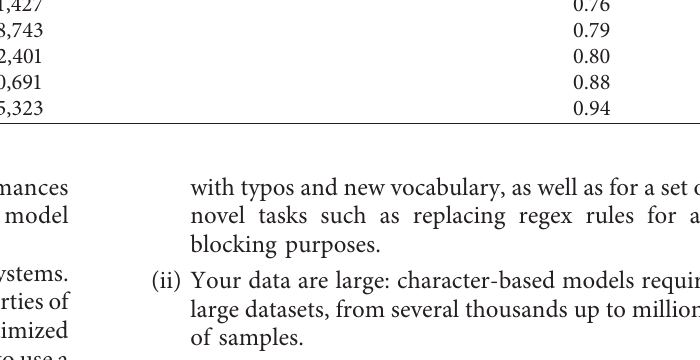
Generative LSTM- independent comp. [30] Generative LSTM-shared comp. [30] Char shallow-and-wide CNN [23] Word shallow-and-wide CNN [23] CharTeC-Net (our